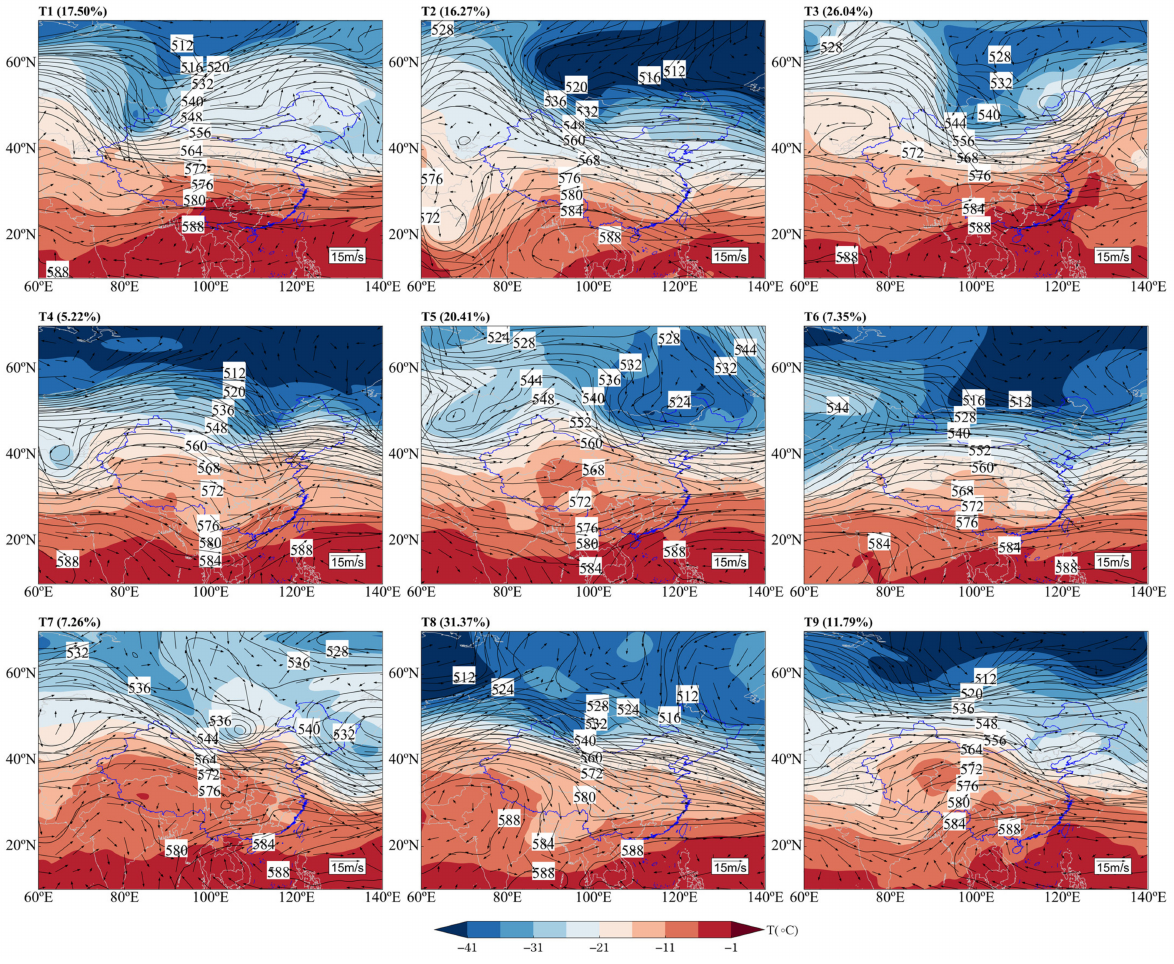
Figure 5. Distribution of the 500 hPa height field, the wind field, and the temperature field of the nine circulation types in the spring from 2000 to